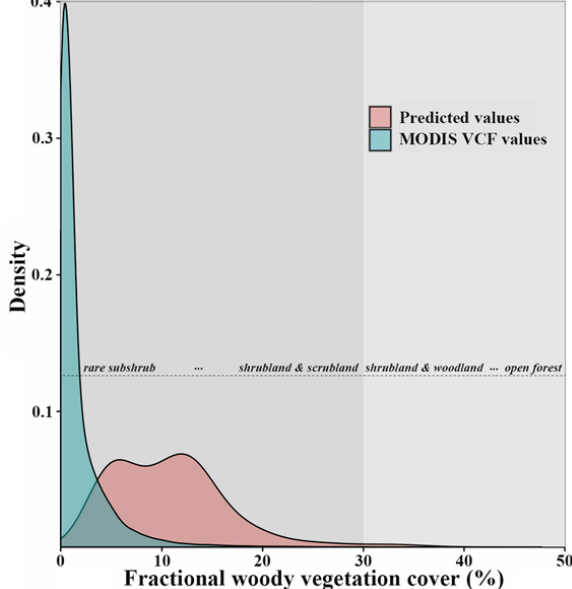
Figure 7. The density distributions of our predicted values (red area) and MIDOS-VCF product values (blue area). They show significant difference in relative low woody coverage value (<30%) represented by the dark part of the figure. From the lowest to the highest proportion of woody cover, the main landscape possibly changes from grassland with rare subshrub to open forest.